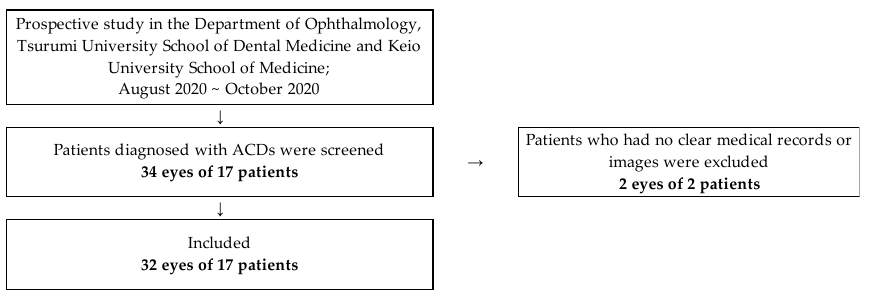
Figure 1. Study flowchart.